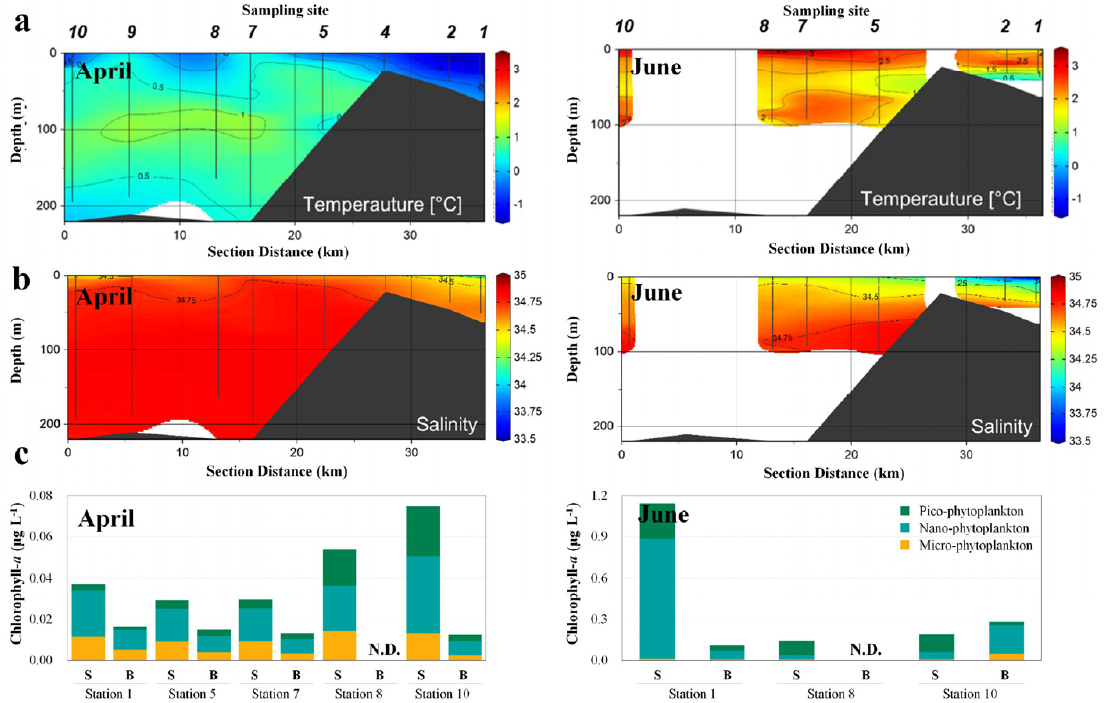
Figure 2. Changes in water temperature ( a ), salinity ( b ), and chlorophyll– a concentration ( c ) in the Sub–Arctic Kongsfjorden in April and June 2018. Water temperature and salinity were measured at sites (St.) 1, 2, 4, 5, 7, 8, 9, and 10 in April 2018, and St. 1, 2, 5, 7, 8, and 10 in June 2018. Sub–sampling